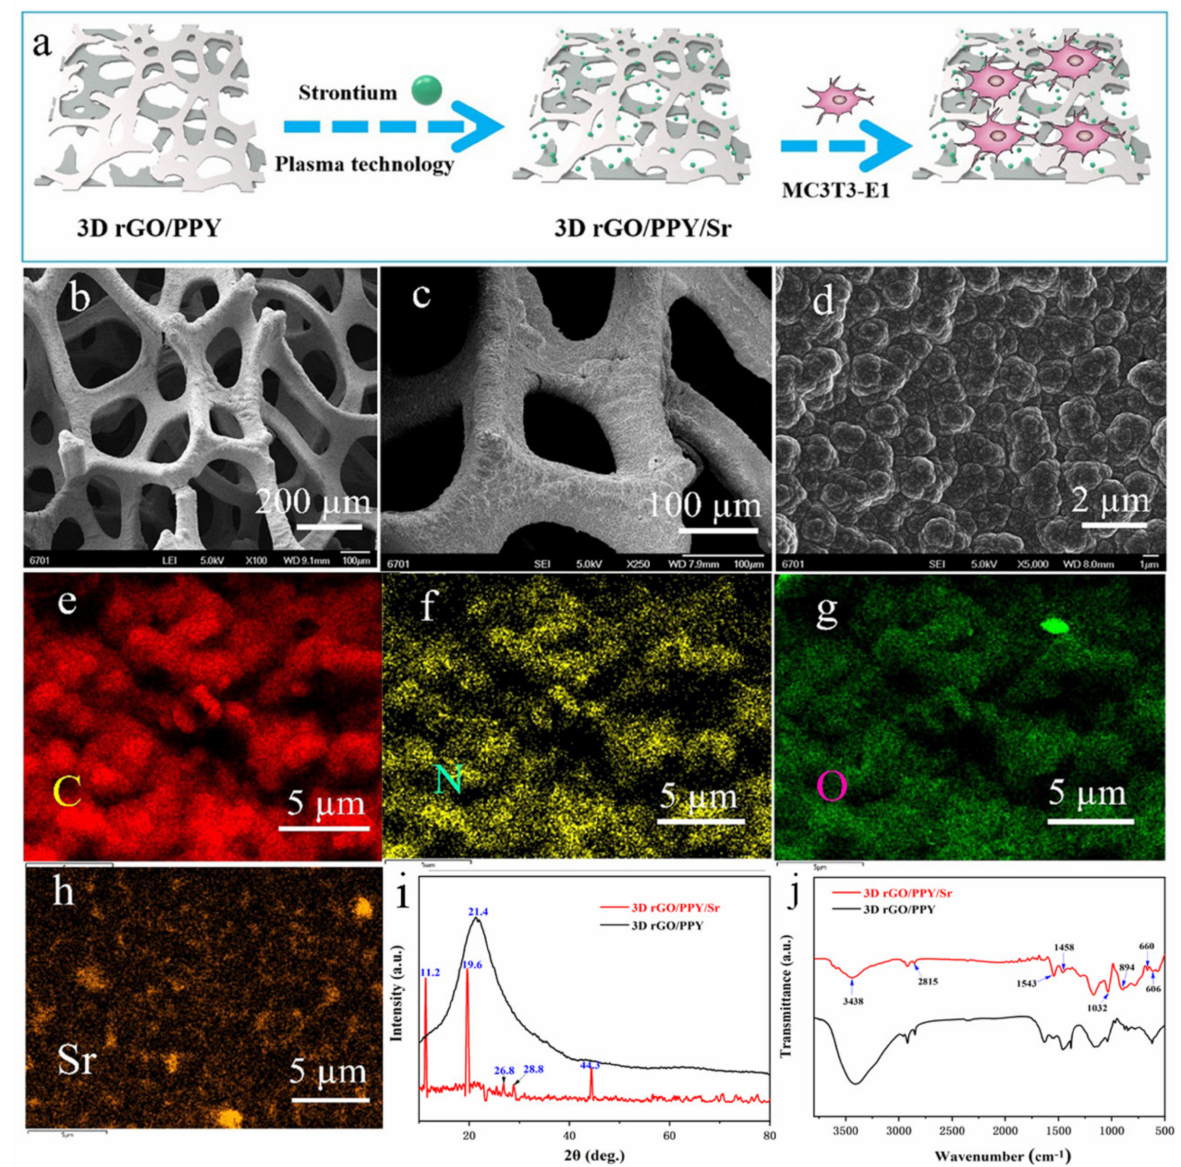
Figure 1. ( a ) Flow diagram of experiment process. ( b – d ) SEM images of the 3D rGO/PPY scaffold, ( e – h ) the EDX results of the 3D rGO/PPY/Sr scaffold. The XRD ( i ) and FTIR ( j ) results of the 3D rGO/PPY before and after Sr modification,